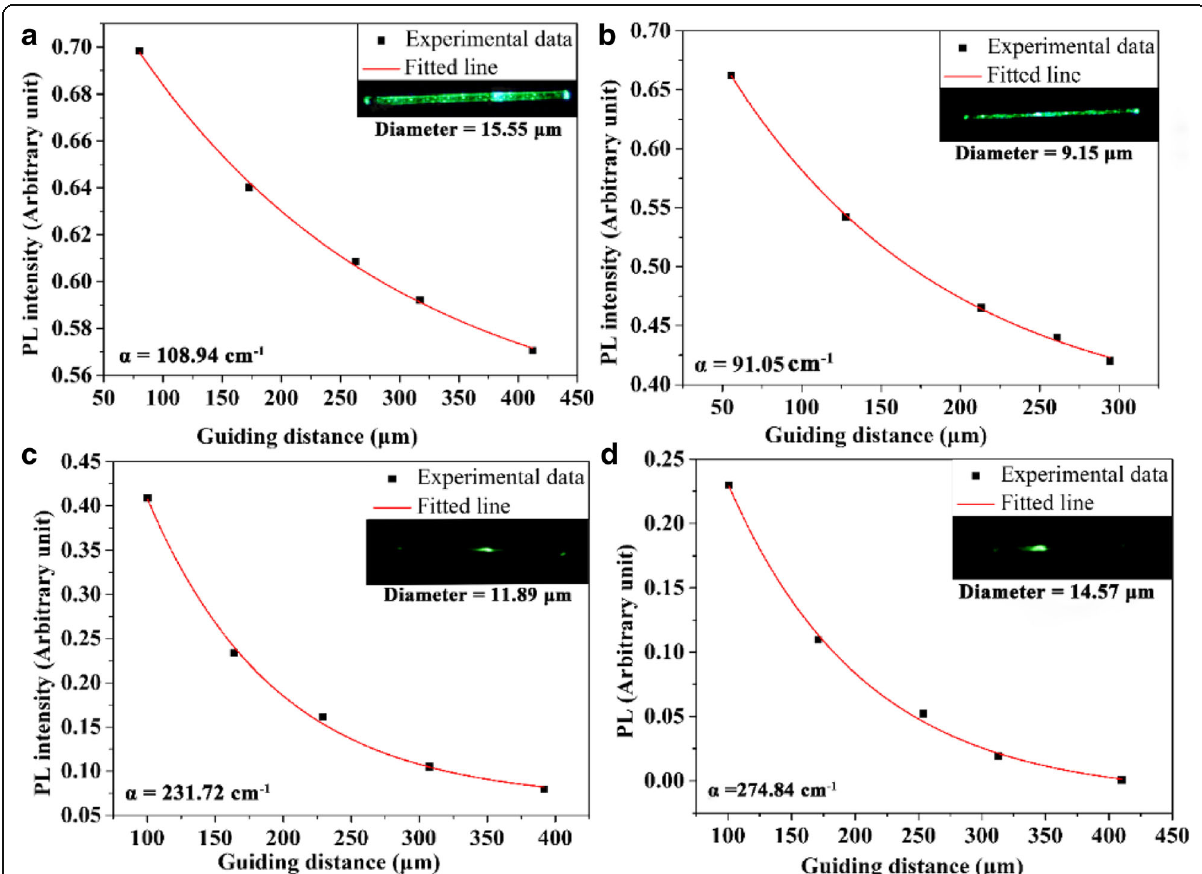
Fig. 7 a , b Fitting lines between photoluminescence (PL) intensity and guiding distance of different diameter of microfibers with Ag co-doped under different excitation point. c – d Fitting lines between photoluminescence (PL) intensity and guiding distance of different diameter of microfibers without Ag co-doped under different excitation